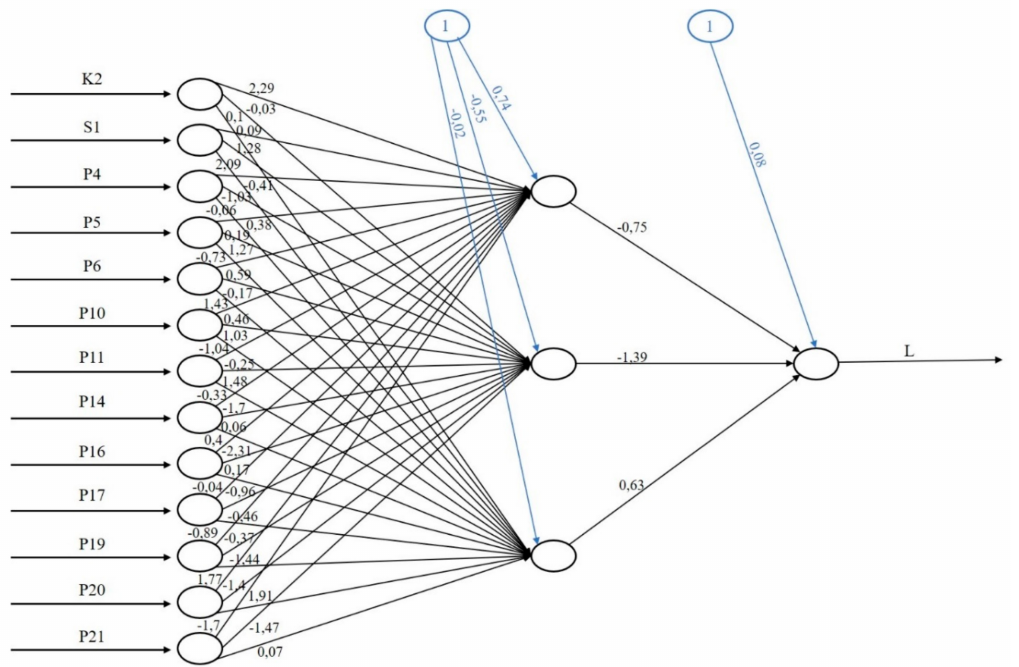
Figure 5. Neural network for the projection of the loyalty of customers by L measure. Source: authors’